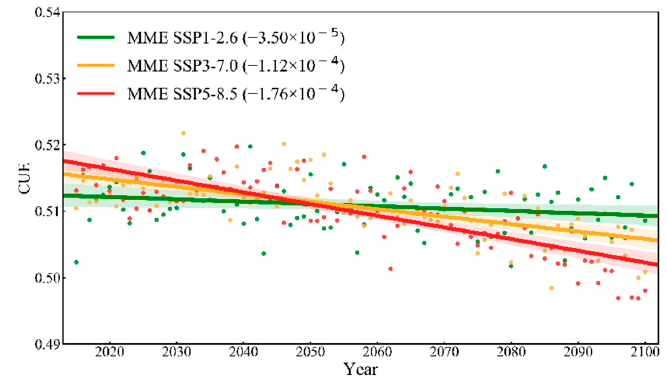
Figure 2. Trend of CUE over the Qinghai-Tibet Plateau during 2015–2100 under the SSP1-2.6, SSP3-7.0 and SSP5-8.5 scenarios as derived from five models and their ensemble mean with the same weights. The tendency rate of CUE is shown in the legend.